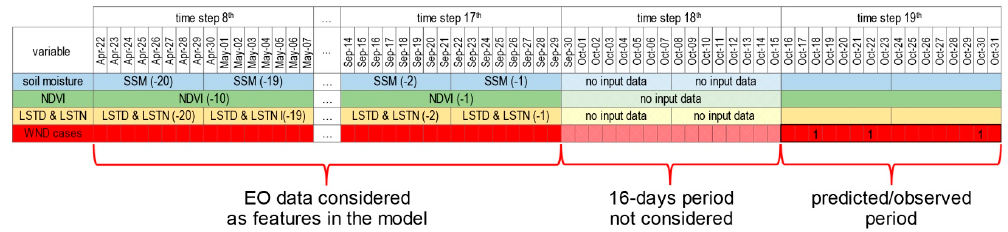
Figure 3. Temporal scheme of West Nile Virus and Earth Observation datasets in each pixel. Time frame of ten 16 day periods is represented: at time step 19th, we have 3 veterinary cases. The previous time step, the 18th, is not considered as input variables; the collection of predictors starts at time step 17th back to time step 8th (for a total of 10 time steps